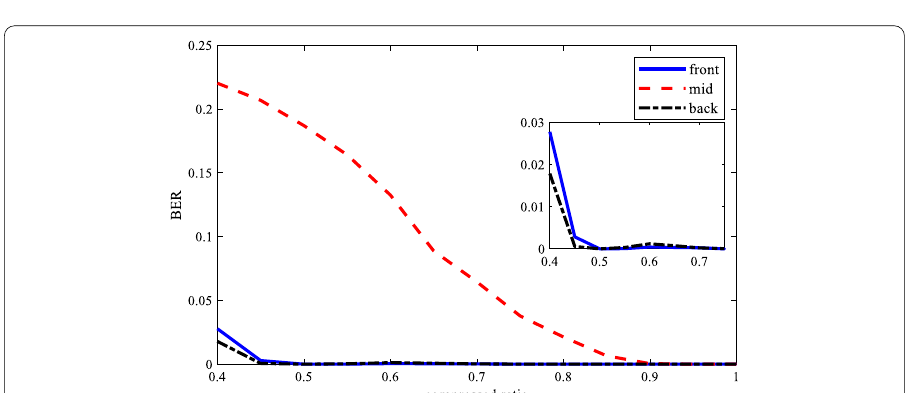
Fig. 3 BER of recovery for compressive OFDM signals with different compressed ratios and truncation filter